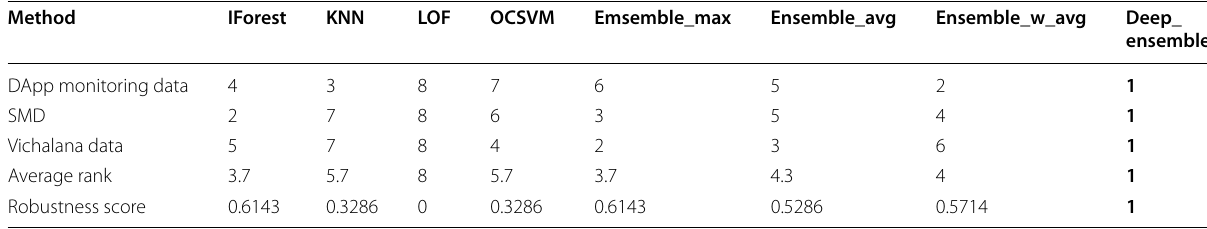
Table 6 Rank results of algorithm robustness